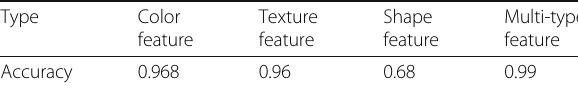
Table 1 Accuracy from different types of feature